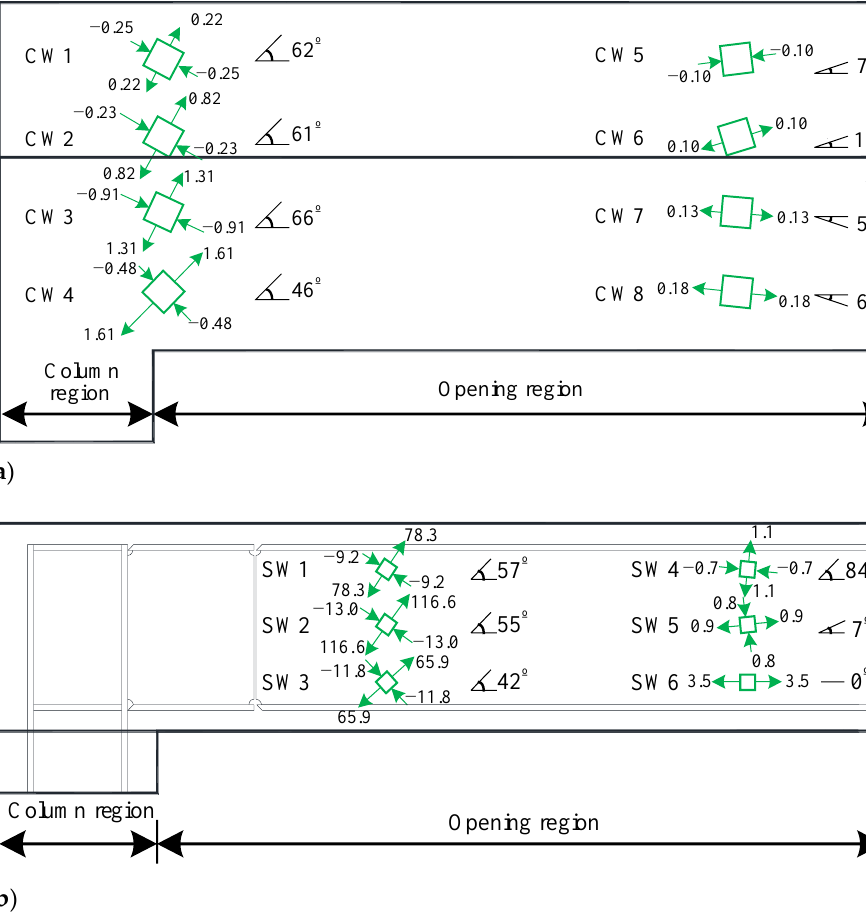
ends, the principal stress direction was not at an angle of 45 ◦ or 135 ◦ to the beam axis.